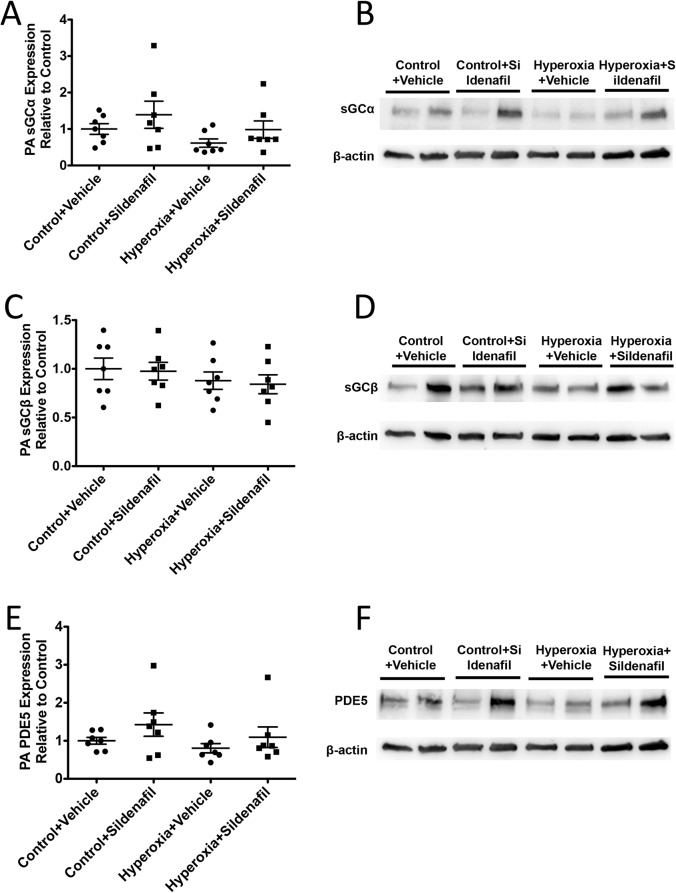
Sildenafil treatment during room air recovery does not affect PA protein expression of sGα, sGCβ, or PDE5.PA protein expression of sGCα (A), sGCβ (C), and PDE5 (E) were measured by western blot and normalized to β-actin (n = 7 animals per group). Representative Western blots are shown for sGCα (B), sGCβ (D), PDE5 (F), and corresponding β-actin. Data are shown as fold changes relative to vehicle-treated controls and are expressed as dot plots with each dot representing individual animals with means and SEM represented by horizontal lines. Results were analyzed by ANOVA with post-hoc Bonferroni’s analysis.